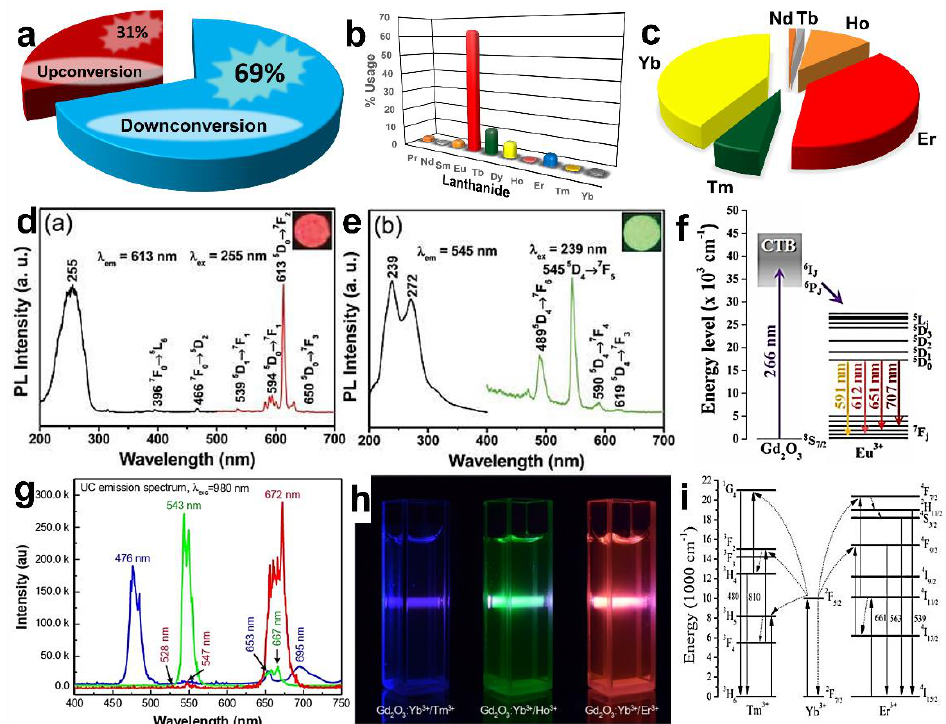
Figure 2. General features of photoluminescent processes by downconversion and upconversion in gadolinium oxide lattices. ( a ) Percentage of publications in the last ten years on the design of gadolinium-based matrices for upconversion or downconversion phenomena. ( b , c ) The most widely used lanthanide dopant. ( d ) Excitation and emission spectra of Eu-doped gadolinium matrices. ( e ) Excitation and emission spectra of Tb-doped gadolinium matrices. ( f ) Energy level diagram and luminescent emission processes in Eu-doped gadolinium matrices. ( g ) Emission lines of Er, Tm, and Ho were used as dopants in Gadolinium matrices. ( h ) Photograph of the photoluminescent emission by upconversion of Gd-based particles with different dopants in colloidal suspension. ( i ) Energy levels diagram describing the radiative and non-radiative processes in Gd-based lattices by upconversion using Yb, Er, and Tm as dopants.